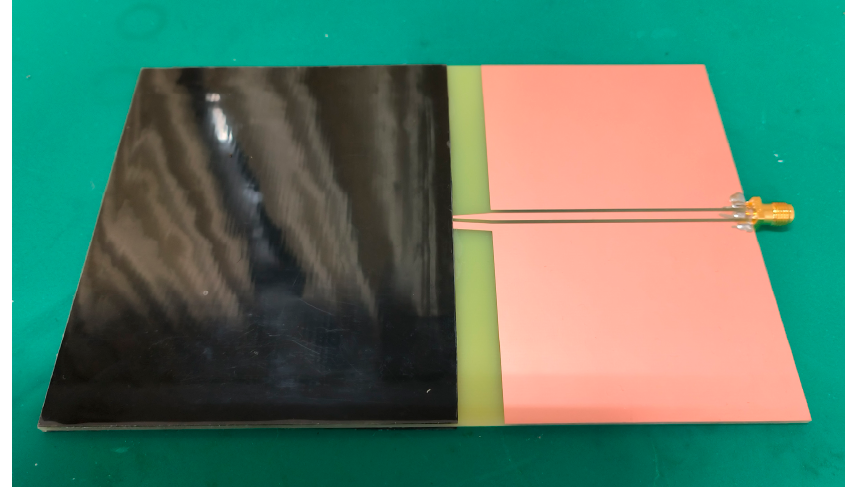
Figure 15. Physical picture of probe.